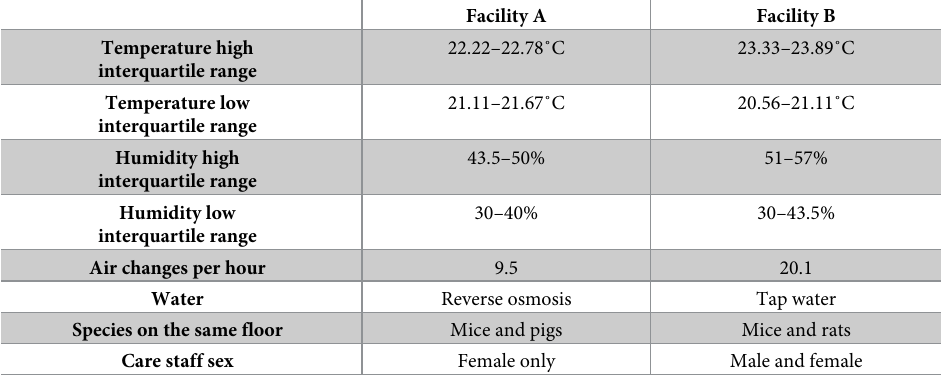
Table 1. Outline of parameter differences between housing rooms in different